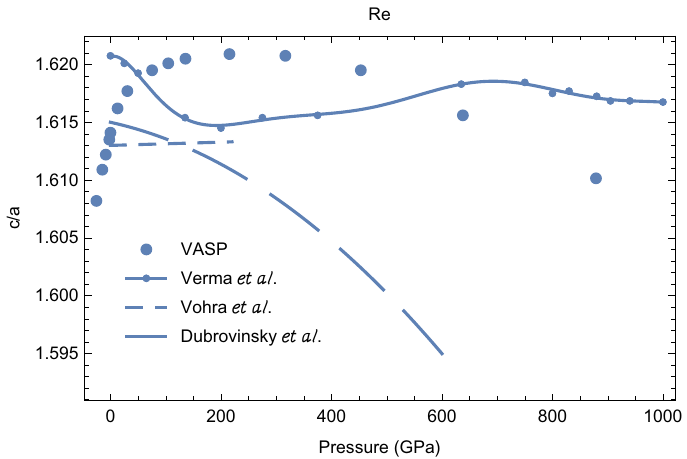
Figure 6. The c/a ratio as a function of P : VASP vs. the available experimental data from different literature sources [3,5,38].